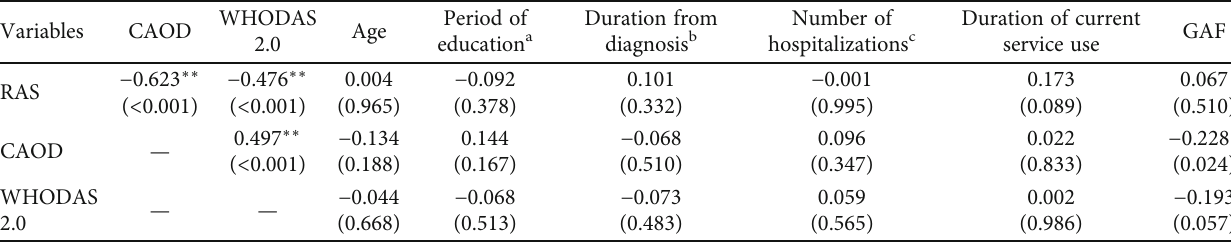
Table 3: Correlations between variables.